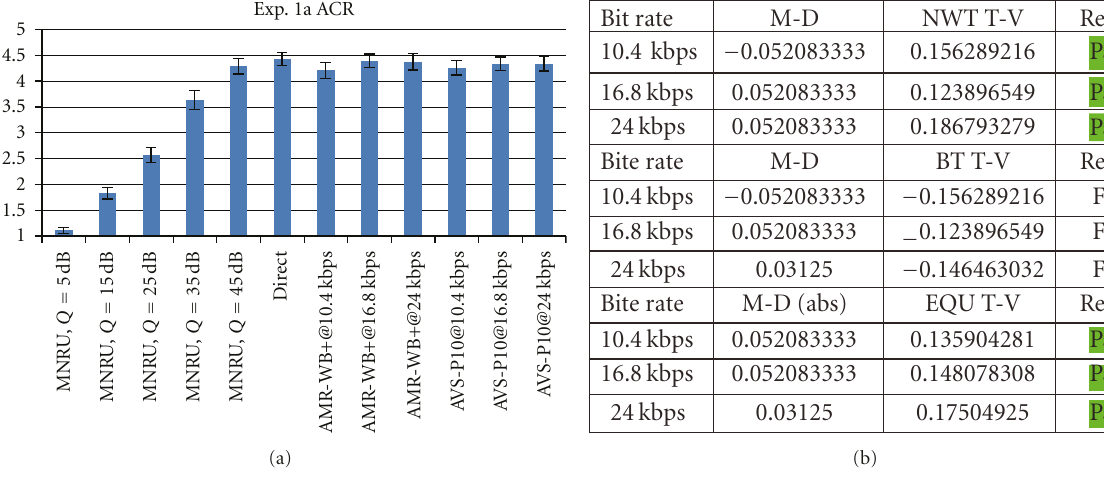
Figure 11: Experiment 1a MOS scores statistic analysis result and T -test result, M-D: mean di ff erence; T-V: T -test value.